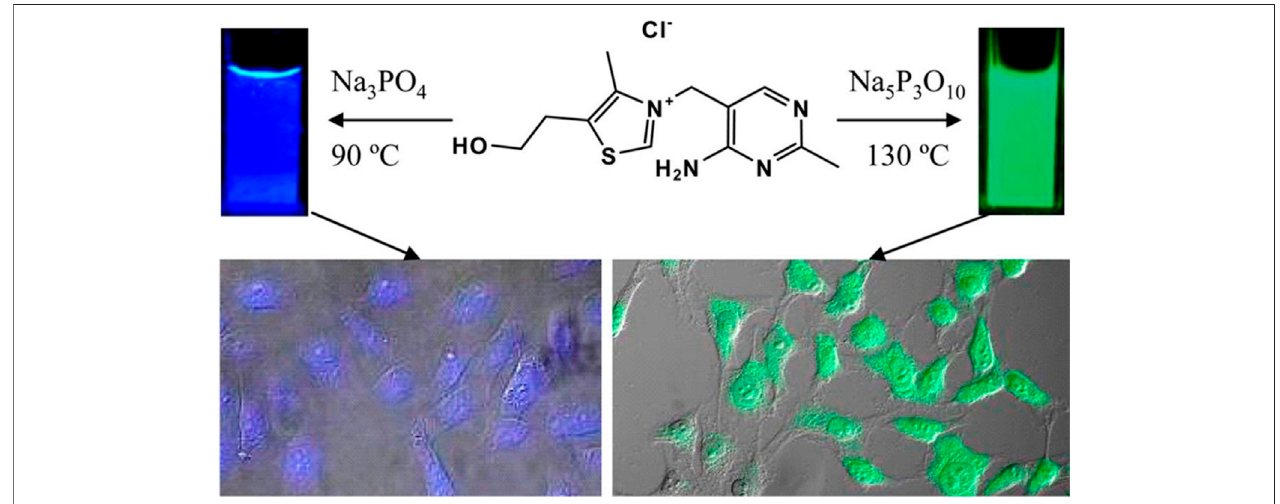
FIGURE6| Synthesisoftunable fl uorescentcarbonnanoparticlesfromvitaminB1.Fluorescentpropertieschangedwithreactiontemperatureandsolvent(Bhunia, Pradhan, and Jana